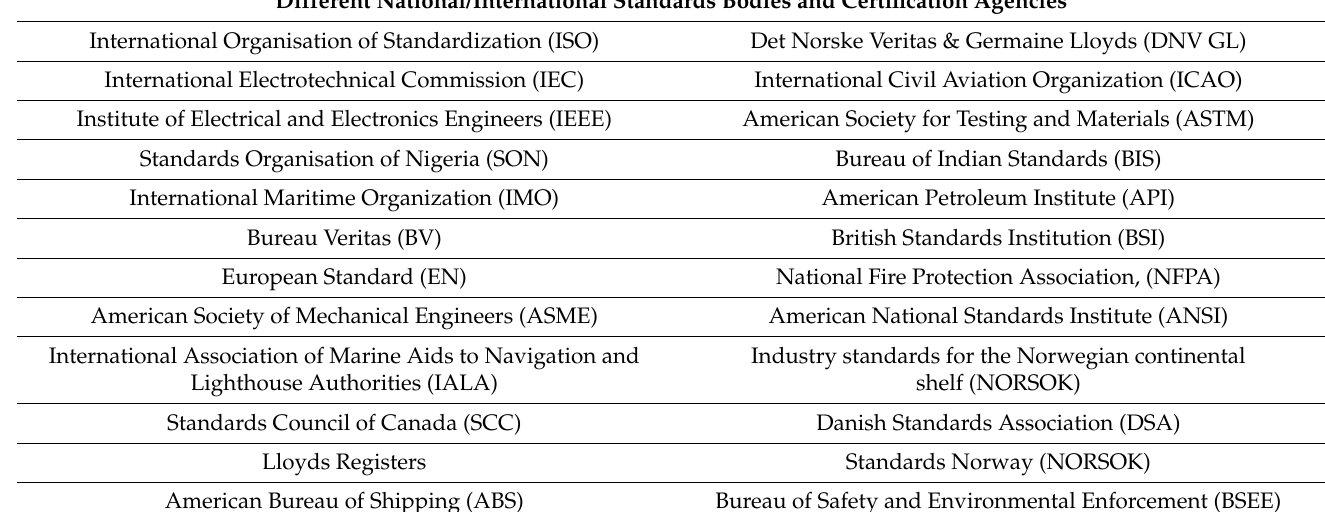
Table 5. List of some standards bodies and certification agencies.